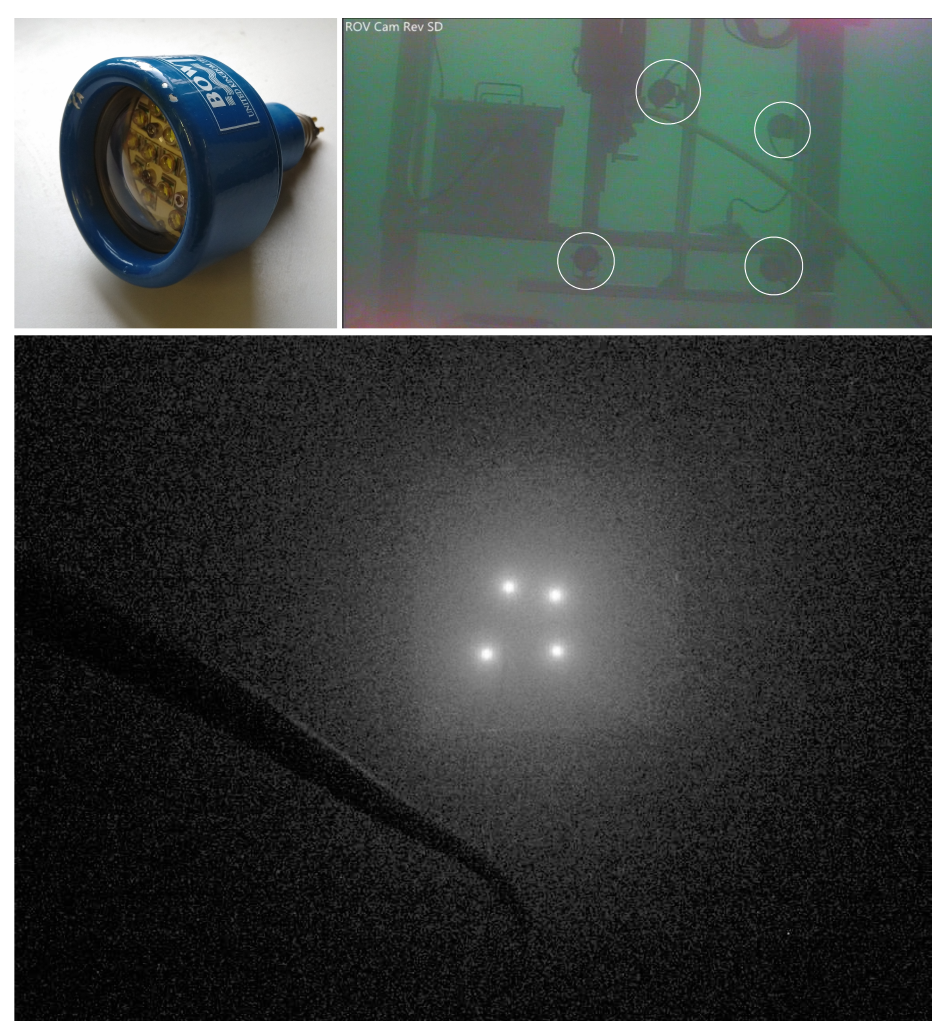
Figure 2. Underwater light used for a light marker attached to the TMS ( top left ); Lights mounted on TMS forming a light marker ( top right )—a photo taken from a rear ROV camera; the light marker observed from approximately 7 m distance ( bottom ); the photo taken using an image acquisition